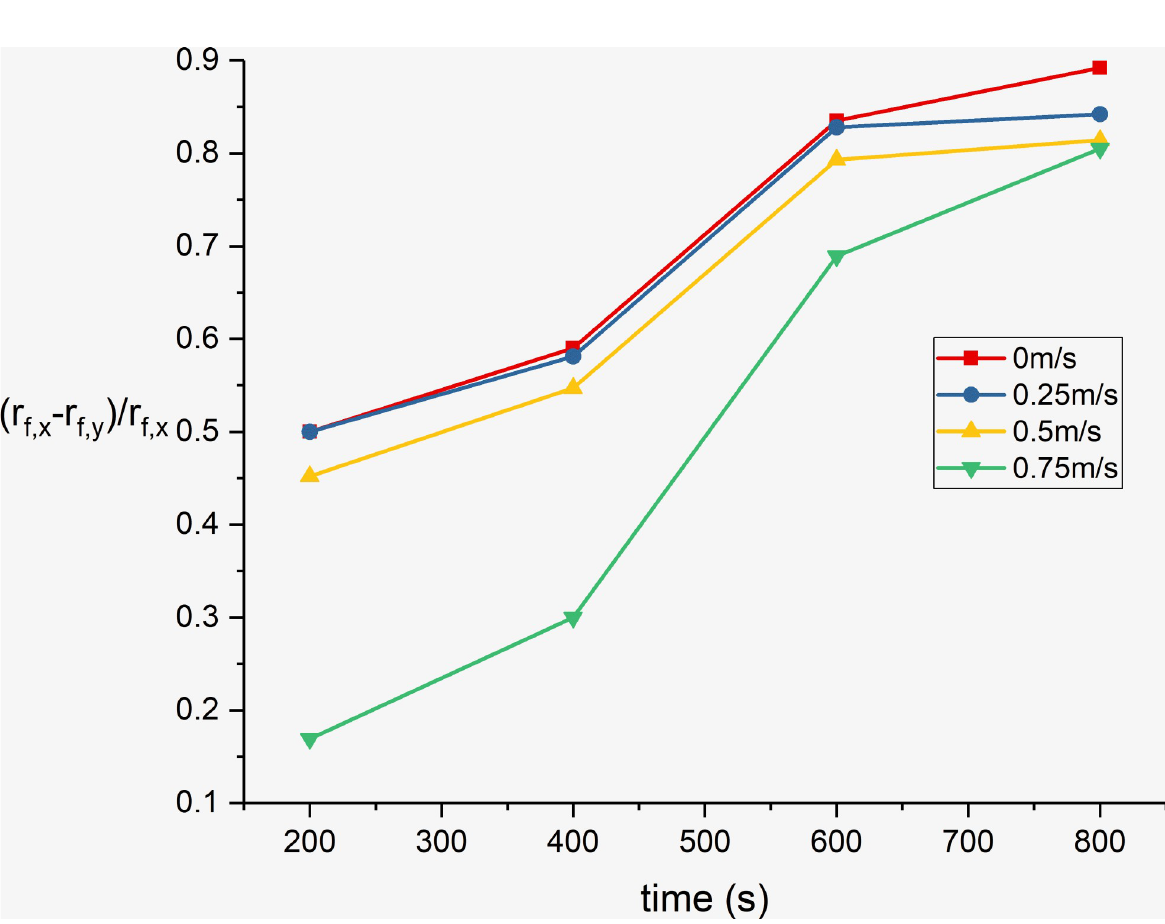
Fig 16. Normalized flame lengths R ( f ) in the x- and y-directions for different wind speeds.